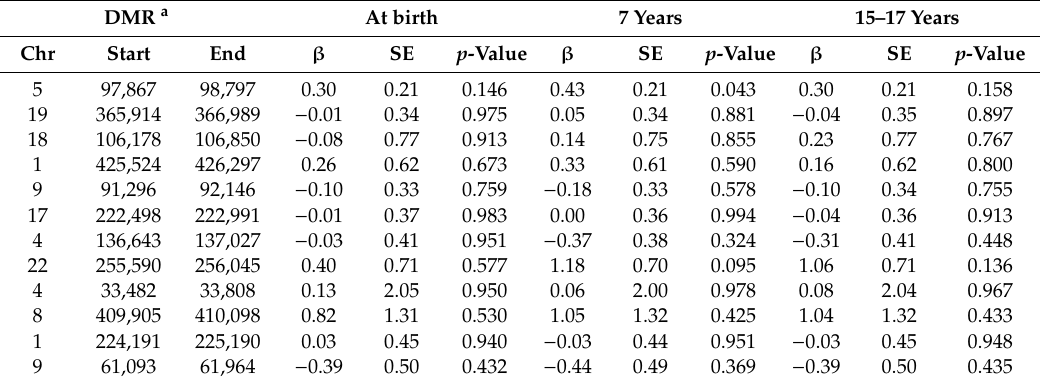
Table 4. Association between peripheral blood DNA methylation at di ff erent ages at each DMR and ever breastfeeding. DMR a